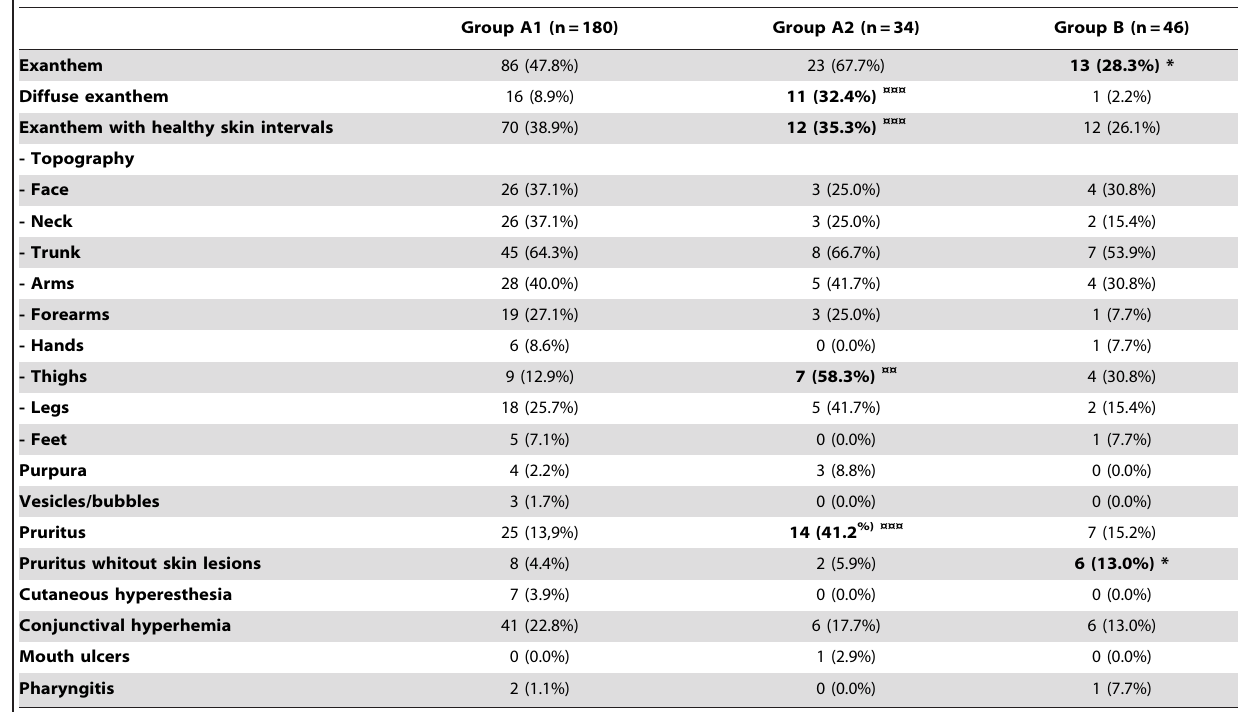
GroupA1:RTPCRCHIKVpositivepatients.GroupA2:RTPCRCHIKVnegative,IgMantiCHIKVpositive,IgGantiCHIKVnegativepatients.GroupB:RTPCRCHIKV negative,IgMantiCHIKVnegative,IgGantiCHIKVnegativepatients. GroupA1vs.GroupA2: ¤¤¤ p , 0.001, ¤¤ p , 0.01, ¤ p , 0,05. GroupA1vs.GroupB: *** p , 0.001,**p , 0.01,*p , 0,05. Average,standarddeviation,percentageinparenthesisareindicated.